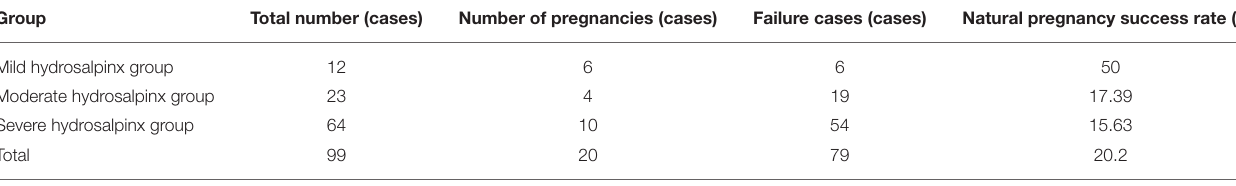
TABLE 3 | Hydrosalpinx and postoperative pregnancy outcome. Group